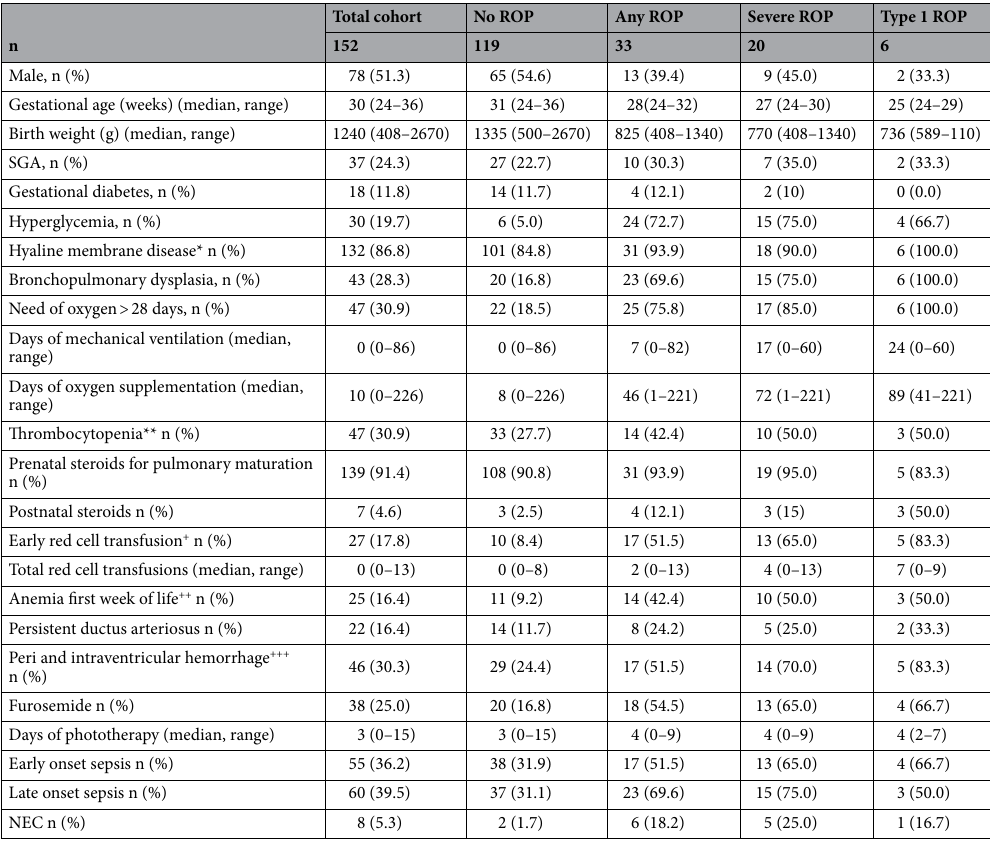
Table 2. Characteristics of the included infants. NEC necrotizing enterocolitis. *Grade 1–4. ** ≤ 50 000 platelets per microlite. + First 10 days after birth. ++ Hemoglobin < 11 g/dl. +++ Grade